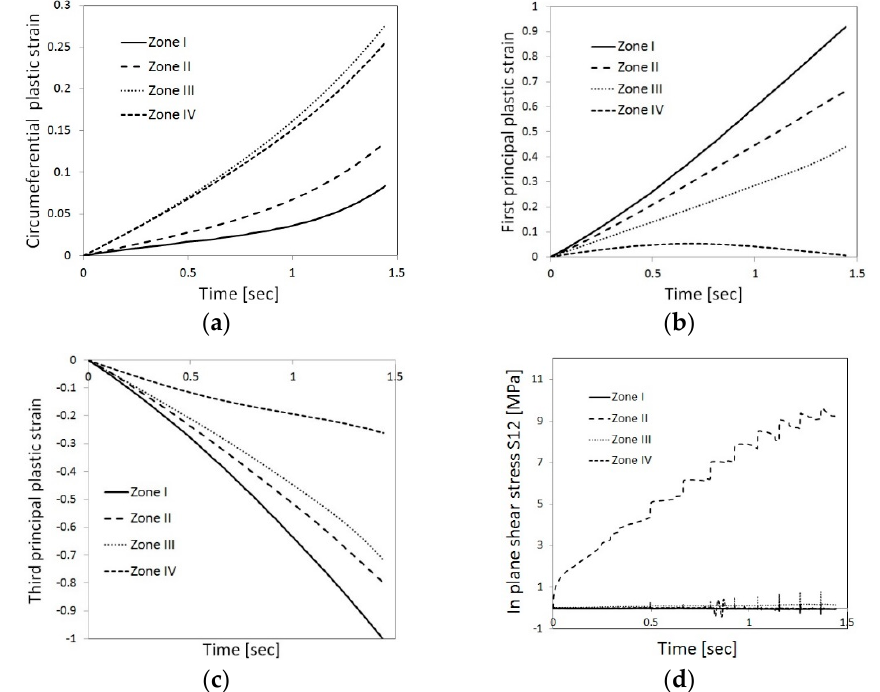
Figure 17. Average values of thermo-mechanical fields within specimen R5 at each zone: Out-of-plane (circumferential) principal strain ( a ), maximum in-plane ( b ), and minimum in-plane ( c ) principal strains, and the shear stress ( d ) evolution with time.